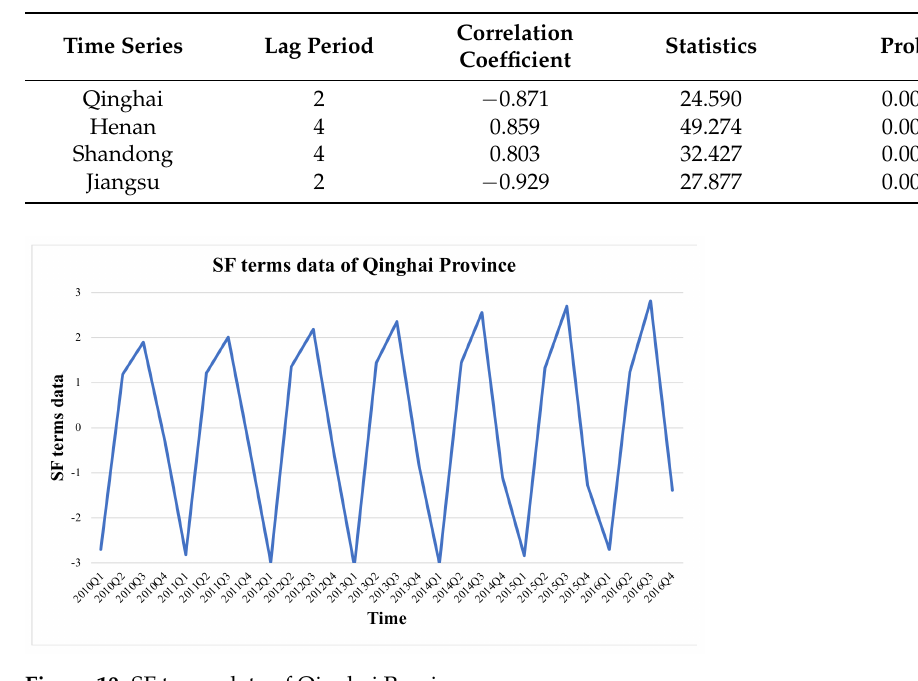
Figure 10. SF terms data of Qinghai Province.